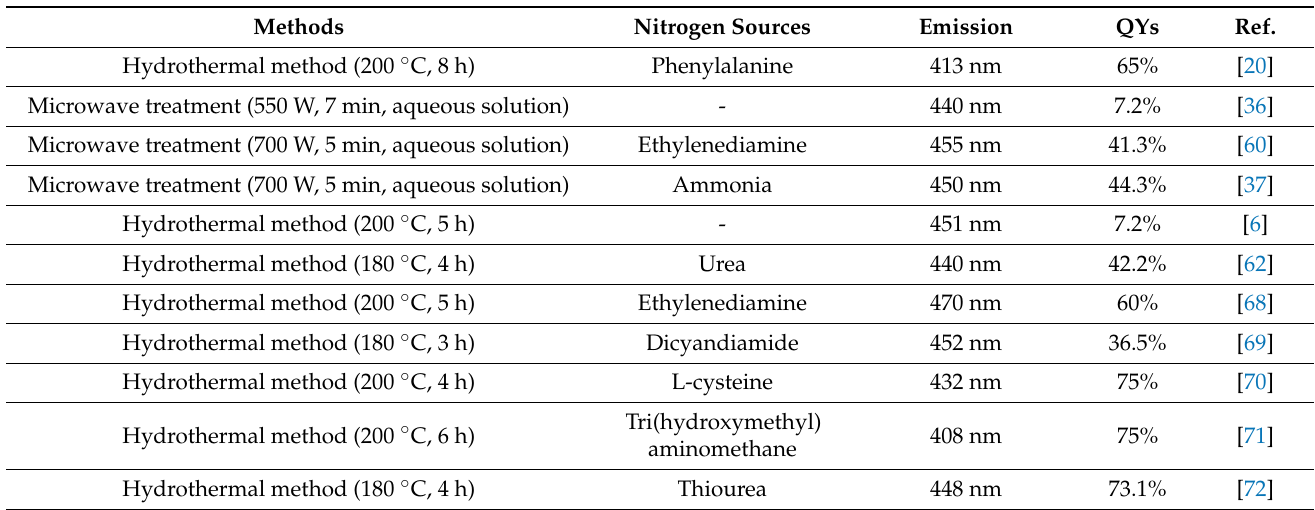
Table 1. The quantum yields of some CA-based CDs with different nitrogen (N) sources. QY: quantum yield.